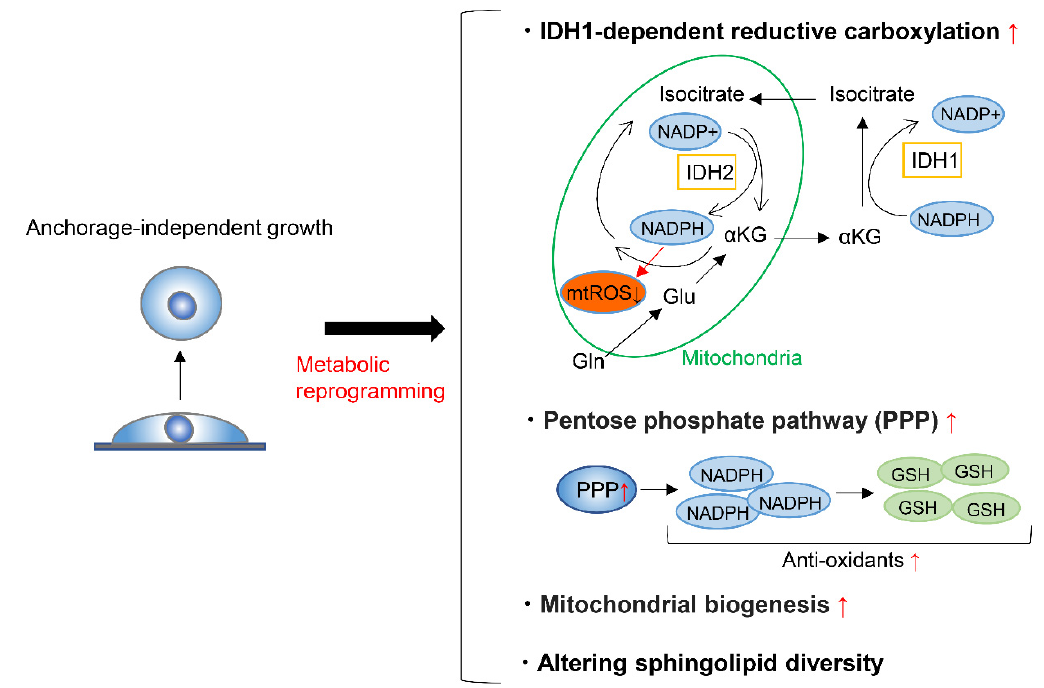
Figure 5. Metabolic reprograming during anchorage-independent growth. Metabolic reprograming during anchorage-independent growth include isocitrate dehydrogenases-1 (IDH1)-dependent reductive carboxylation of glutamine, upregulation of pentose phosphate pathway, the enhancement of mitochondrial biogenesis and respiration, and altering sphingolipid diversity. mtROS; mitochondrial reactive oxygen species, GSH; glutathione-SH.